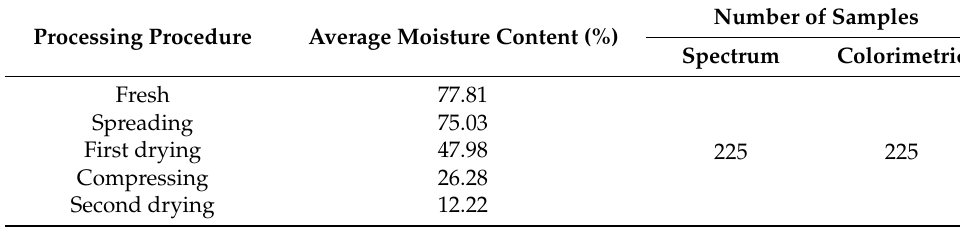
Table 1. Moisture content of Longjing tea during the entire processing